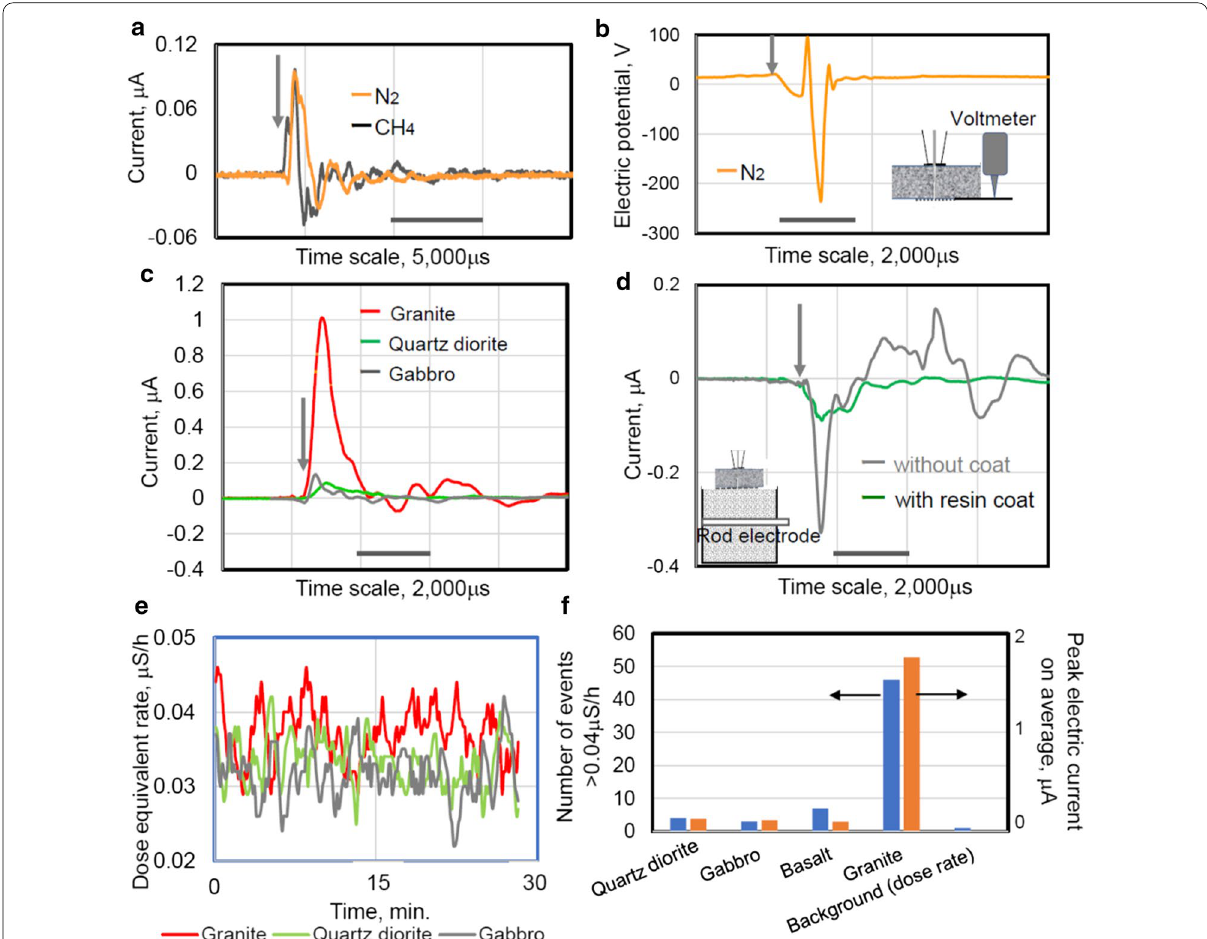
Fig. 3 a and b Typical results for third series of experiments. a Currents for combination of gabbro/CH 4 or N 2 at ~ 160 °C, which are enlarged the signals in the middle of Fig. 2e; b electric potential for gabbro/N 2 at ~ 160 °C. c and d Typical results for fourth series of experiments. c Current and vibration for combination of granite/CO 2 at ~ 25 °C and d induced current signals at the pipe electrode with and without non-conductive resin coating buried in a container filled with granite grains and soil. Arrows show in a – d the final rupture point when the gas started to flow in the crack gap. e Gamma-ray equivalent dose rate for granite, gabbro, and quartz diorite in 30-min measurements. f Comparison number Nγ >0.04 of events for the γ-ray equivalent dose rate greater than 0.04 μSv/h and average peak currents for several test runs of quartz diorite, gabbro, basalt, and granite with CO 2 at S 1.2 10 –4 m 2 and ~ 25 °C; Nγ >0.04 for the background in open air is also included. Arrows pointing to the left and right indicate the = × vertical axis showing the units of the blue and orange bar